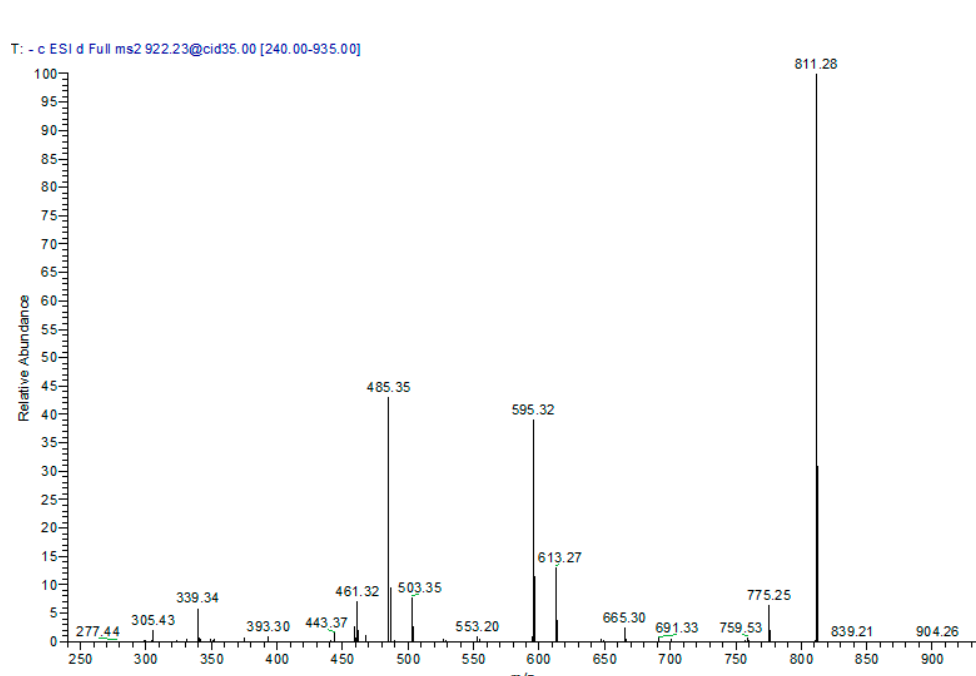
Figure 7. Negative ion ESI-MS/MS spectra of bis-dihydroxyphenylpropanoid-substituted catechin rhamnosyl-hexoside at [M − H] − m / z 921.